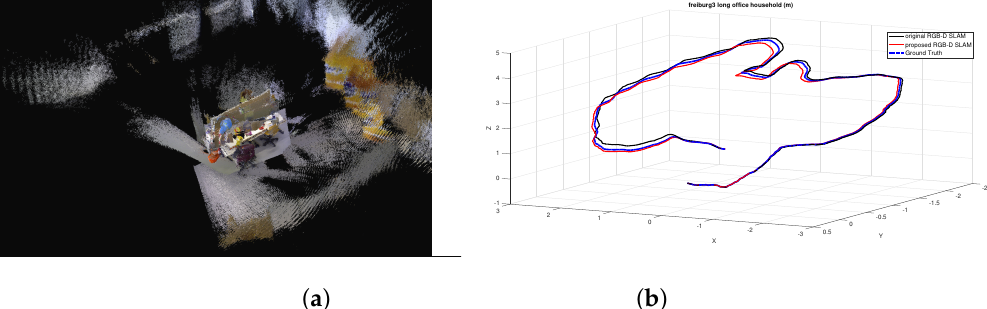
Figure 3. Experimental results of the proposed RGB-D SLAM with sequence fr3/long_office_household. ( a ) Mapping results in the form of volumetric 3D model. ( b ) Estimated